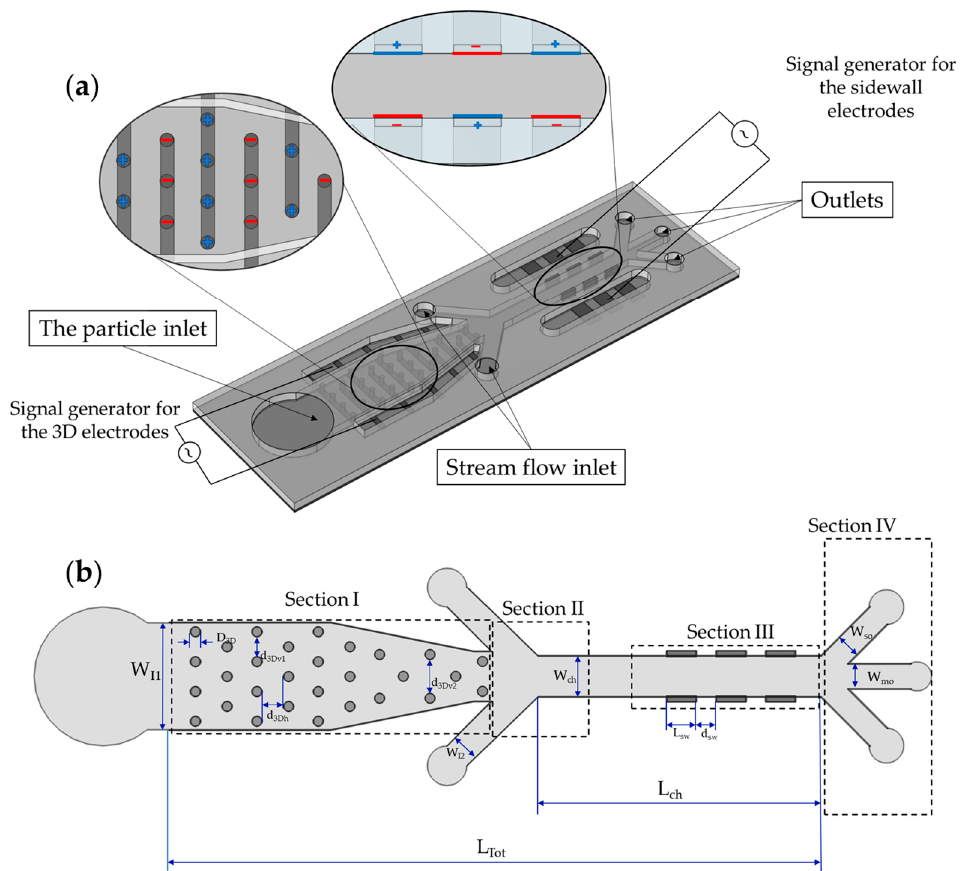
Figure 1. ( a ) Schematic of the microfluidic device; ( b ) Top view of the microfluidic channel with di ff erent sections.